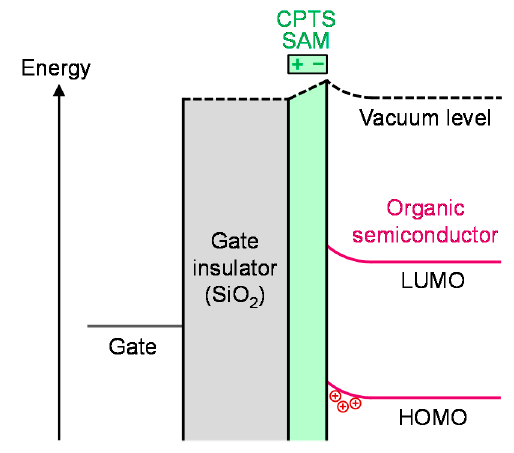
Figure 3. Schematic energy band diagram for bottom-gate OFETs with SiO 2 gate insulators treated with the CPTS SAM; LUMO: lowest unoccupied molecular orbital; HOMO: highest occupied molecular orbital; SAM: self-assembled monolayer. The field-effect mobility of the P3HT FET devices with L = 5 μ m on the CPTS-treated gate